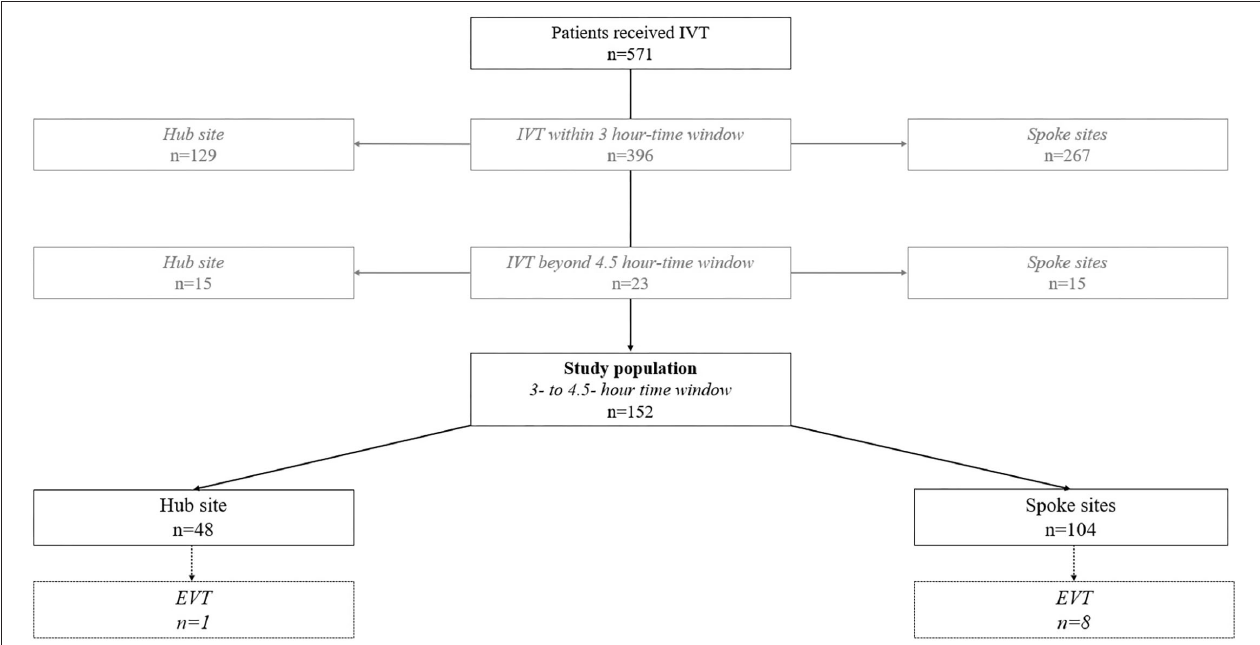
FIGURE 2 | Flow chart of the study population. IVT, intravenous thrombolysis; EVT, endovascular